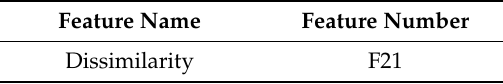
Table 4. Statistical feature matrix